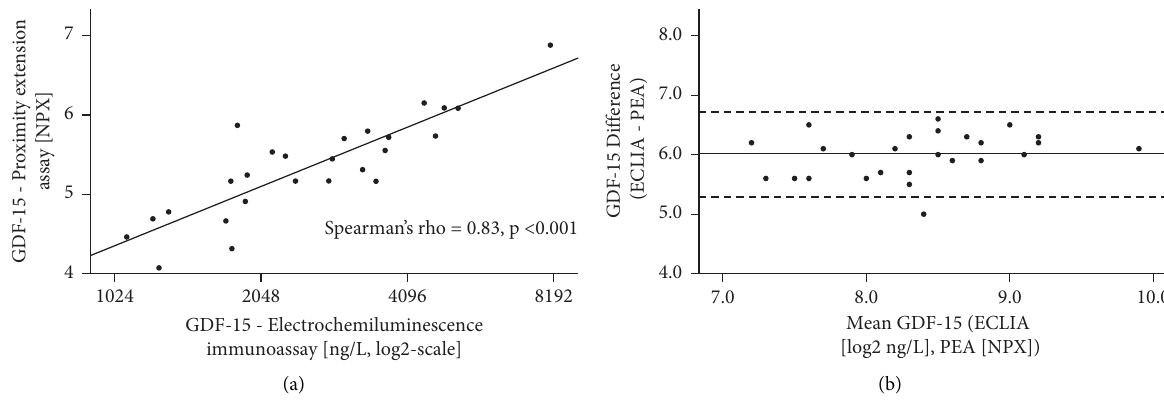
Figure 2: Correlation of GDF-15 values measured with the two methods. (a) Correlation of GDF-15 concentrations measured with electrochemiluminescent immunoassay (ECLIA) and proximity extension assay (PEA). PEA values are expressed in NPX (normalized protein expression), an arbitrary unit on log2 scale, ECLIA values in ng/L on a log2 scale. (b) Bland–Altman plot showing the agreement between the two methods. PEA values are expressed in NPX, and CMIA values have been log2-transformed. Te continuous line shows the mean diference between the two assays, the dotted lines 1.96x standard